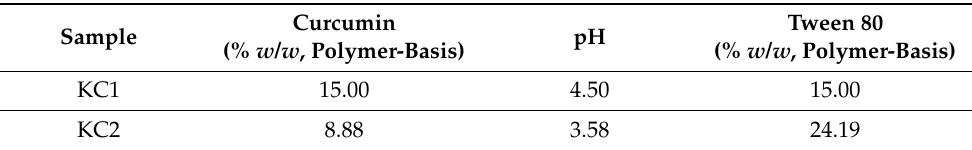
Table 6. Formulation of the particles produced by solid dispersion.